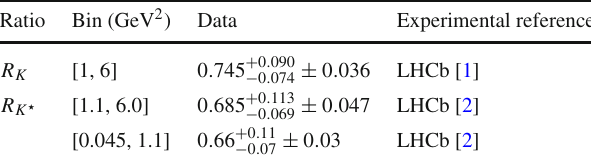
Table 1 Data on R K ((cid:2)) by the LHCb collaboration Ratio